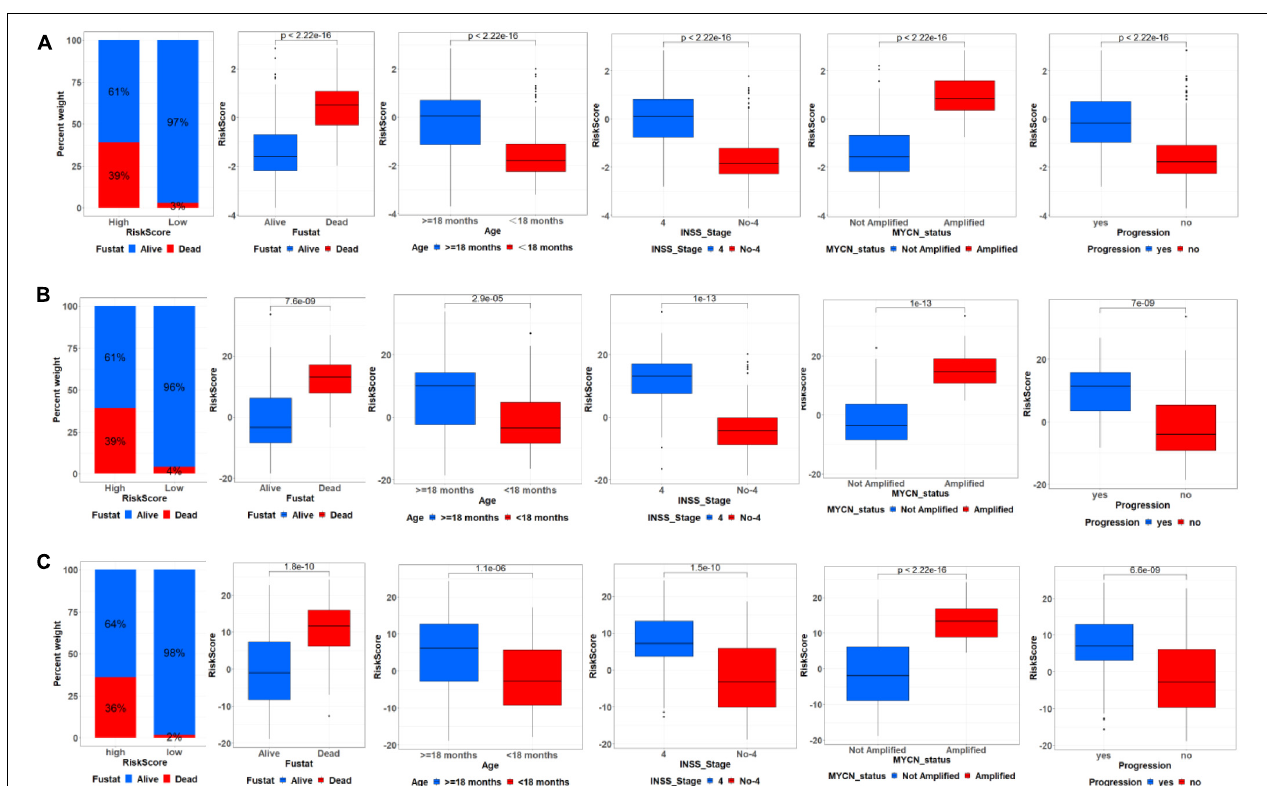
FIGURE 4 | Correlation between ATG signature and clinical characteristics. Relationship between ATG signature and clinical characteristics including outcome, age, INSS stage, MYCN status, and progression in training cohort (A) , internal (B) , and external validation (C)